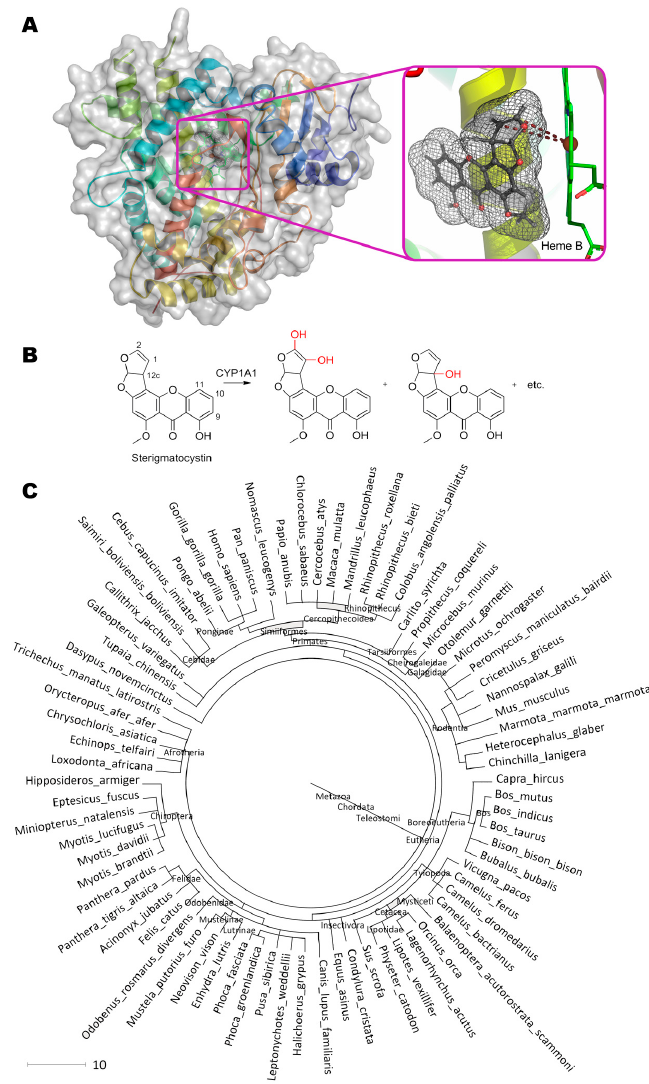
Figure 3. ( A ) Structure of cytochrome P450 (PDB 4i8v) containing sterigmatocystin in its active center, and ( B ) scheme of substrate conversion with cytochrome. Position and geometry of substrate binding was determined as described early. ( C ) Phylogenetic tree of organisms possessing homologous enzymes found with BLAST.